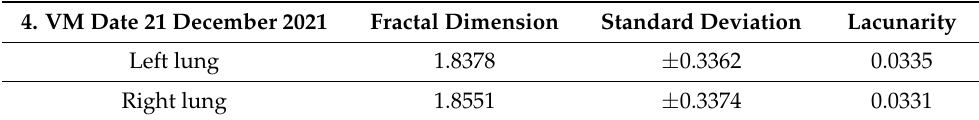
Table 4. Calculation of the fractal indicators for patient 4 .